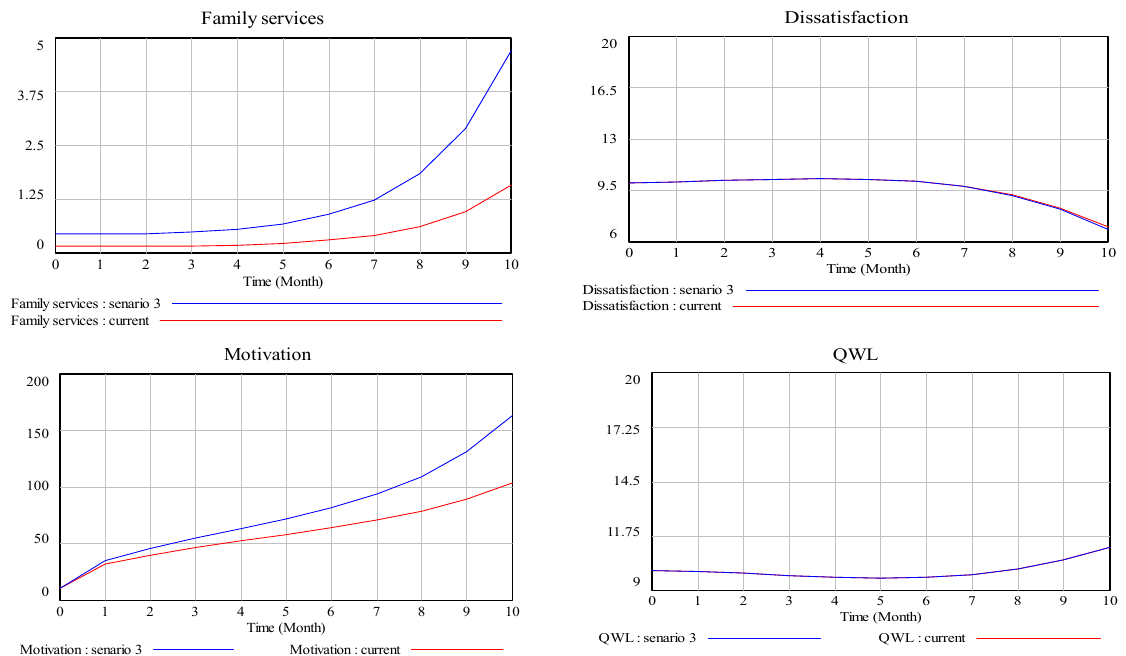
Fig. 7: The Impact of family services improvement on the model variables Fig. 7. The Impact of family services improvement on the model